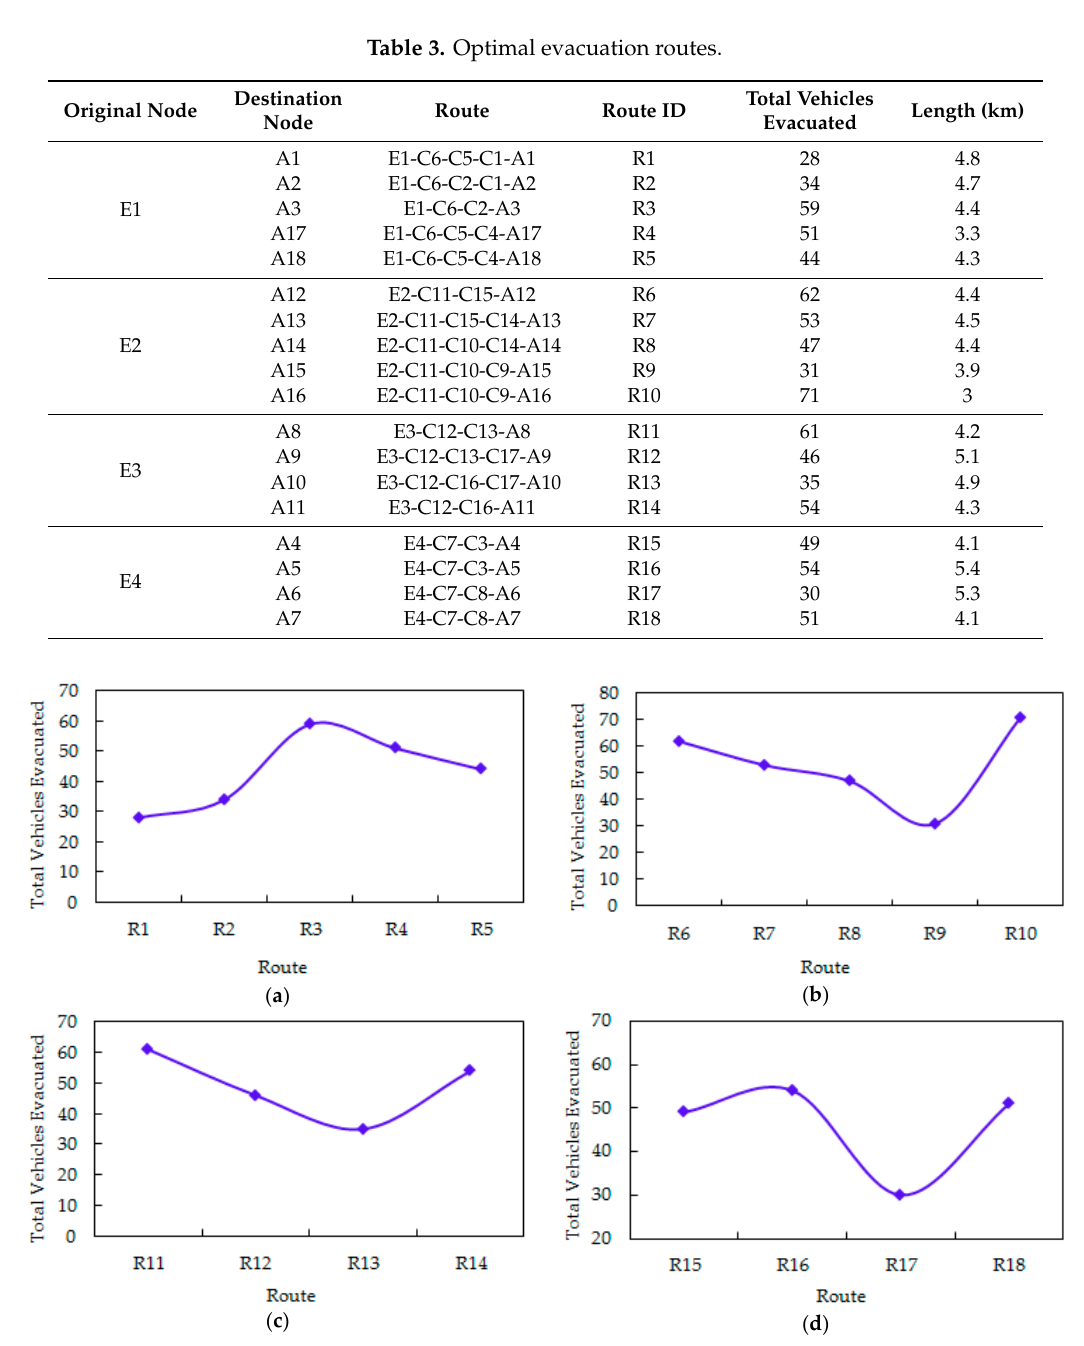
Figure 5. Total vehicles evacuated along different optimal routes from the four exits of the parking lot. ( a ) Exit E1. ( b ) Exit E2. ( c ) Exit E3. ( d ) Exit